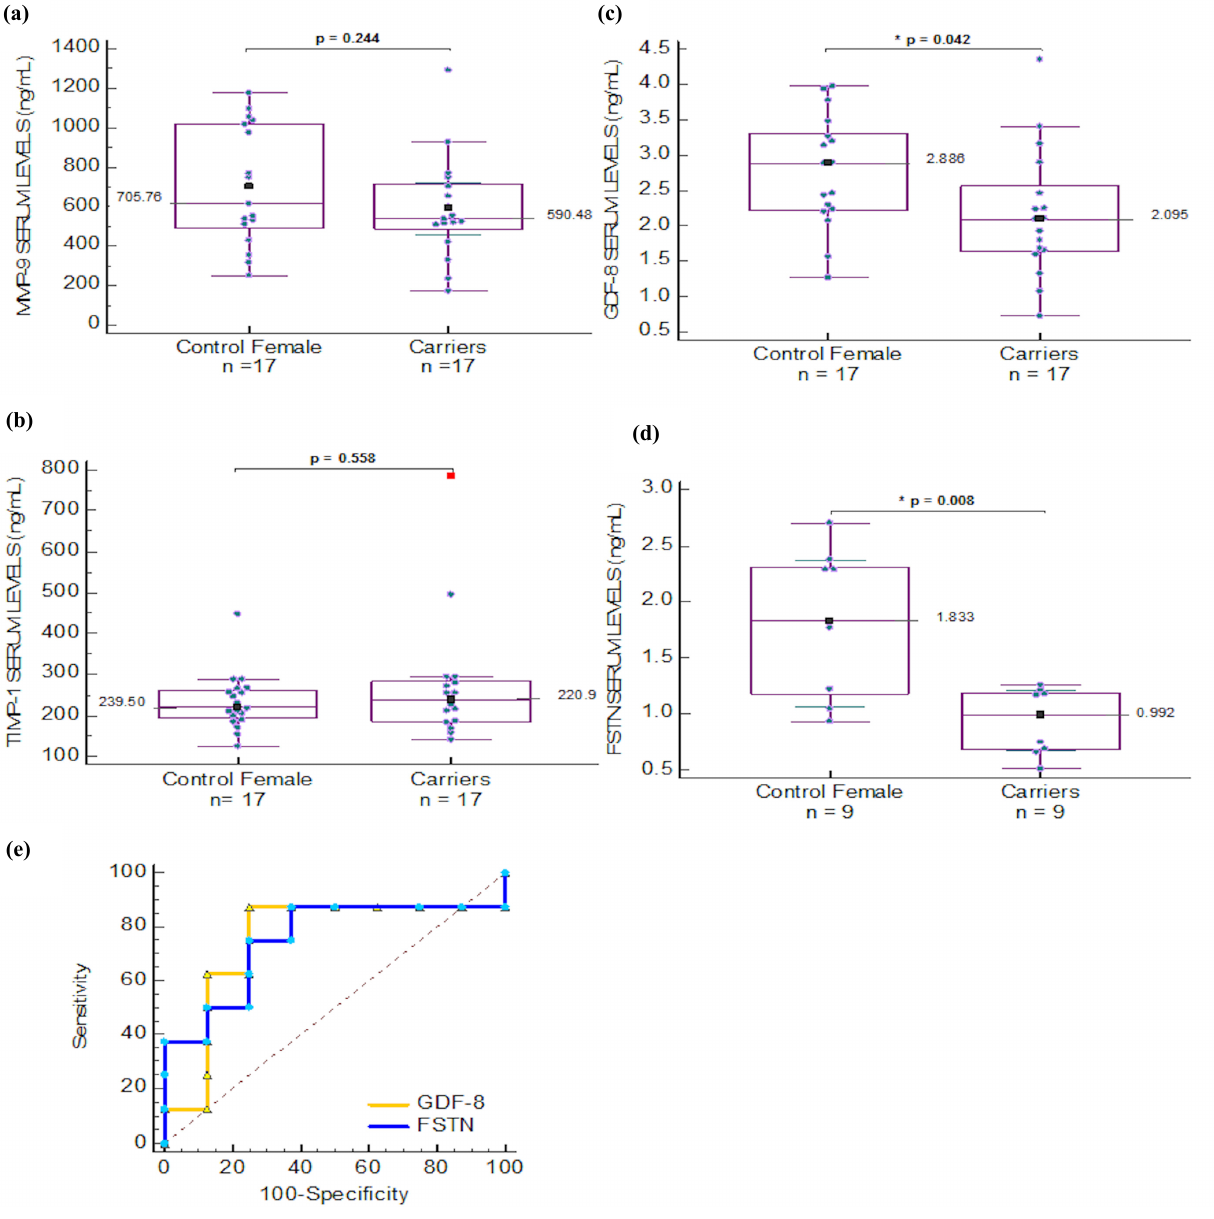
Figure 3. Comparison of ( a ) MMP-9; ( b ) TIMP-1; ( c ) GDF-8 and ( d ) FSTN serum levels in female group; ( e ) ROC curve analysis of GDF-8 ( ∆ ) and FSTN ( ● ) levels in female serum